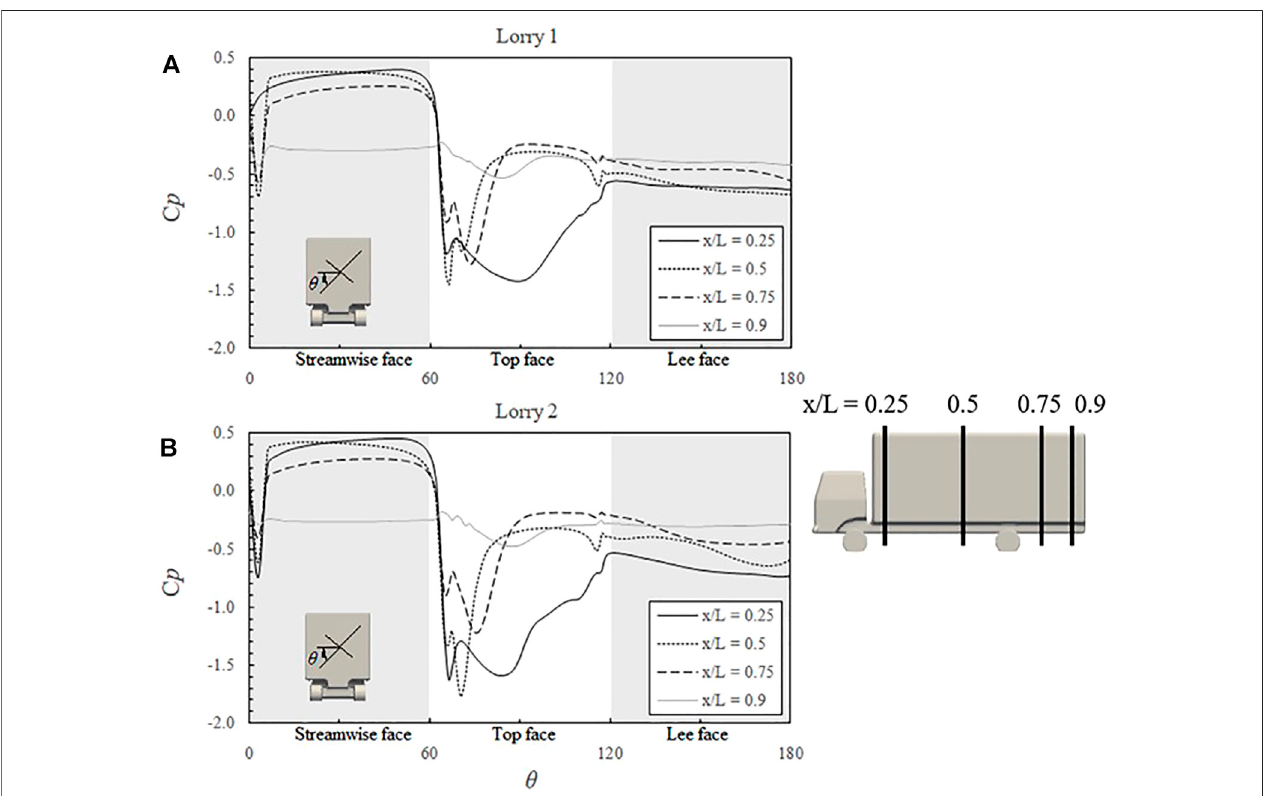
FIGURE 10 | Comparison of the distribution of pressure coef fi cient along the surface distance around the box of the lorry at a different stream-wise distance (A) . lorry 1; (B) lorry two.